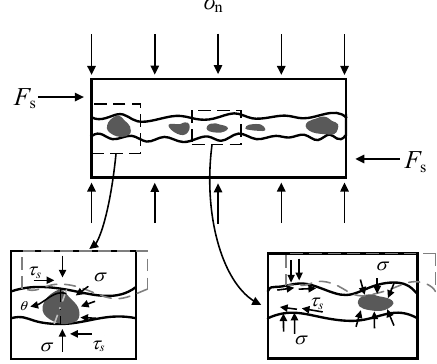
( b ) σ n = 0.4 MPa Figure 17. Cumulative energy dissipation: ( a ) σ n = 0.2 MPa and ( b ) σ n = 0.4 MPa.